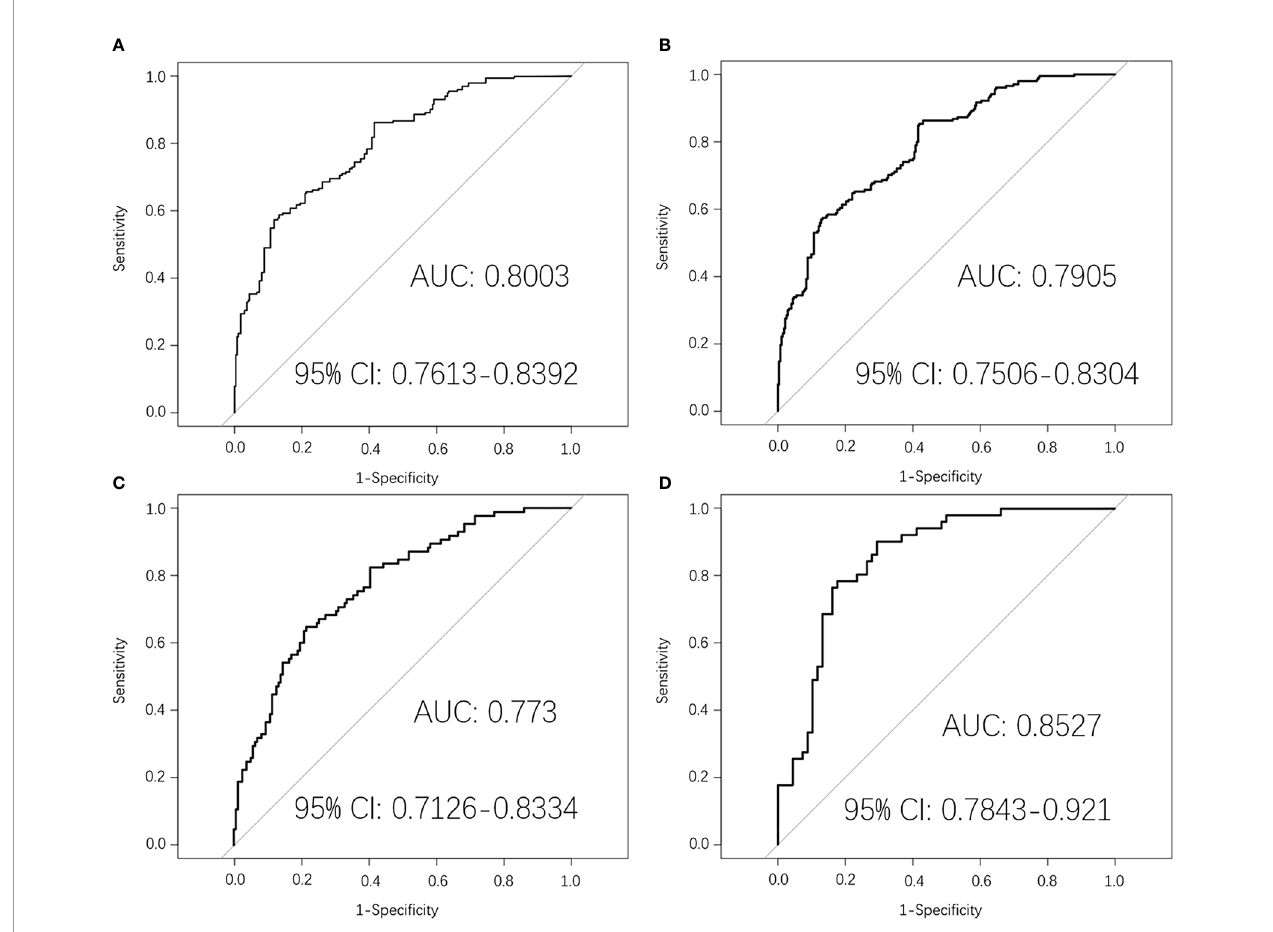
FIGURE 2 | Pre-treatment MRI-radiomics model in each dataset predicted the ROC curves of the PFS in LA-NPC. (A) shows the ROC curve of the MRI-radiomics model in the training dataset of pre-treatment, and (B) shows the average ROC curve of 10-fold cross-validation of the MRI-radiomics model in the training dataset. (C, D) represent the ROC curve of the MRI-radiomics model in the original dataset and test dataset,